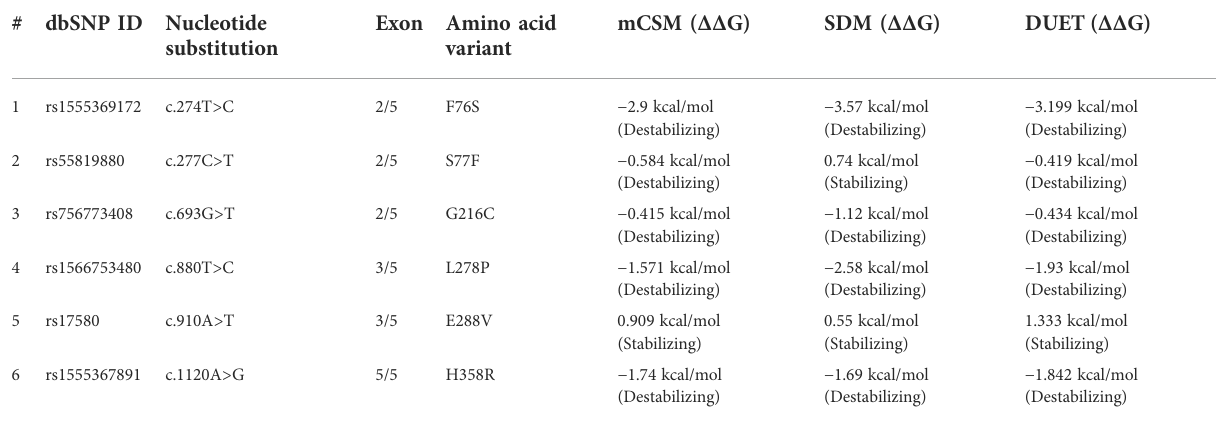
TABLE 4 Thermodynamic stability analysis of SERPINA1 missense